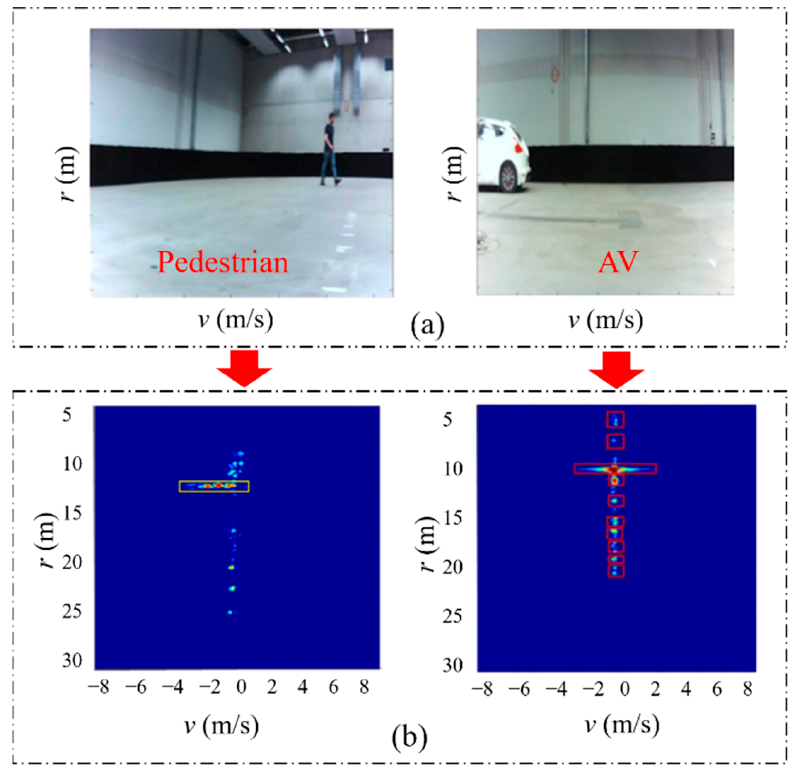
Figure 8. Demonstration of a particular scenario of a pedestrian and a moving autonomous vehicle (AV). ( a ) Digital images; ( b ) RADAR information of the scene using support vector machine (SVM) and multi-objective optimization [84].